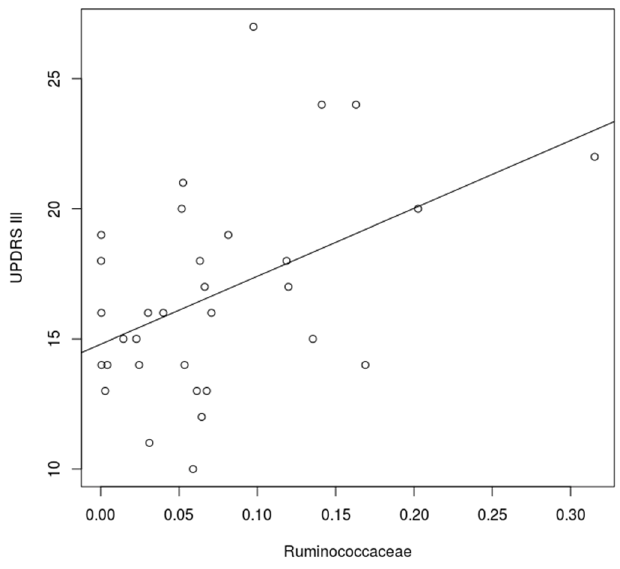
Figure 8. Correlation between frequency of Ruminococcaceae and UPDRS III. There was a significant correlation between the frequency of Ruminococcaceae and UPDRS III in both interventional groups combined ( p = 0.003).